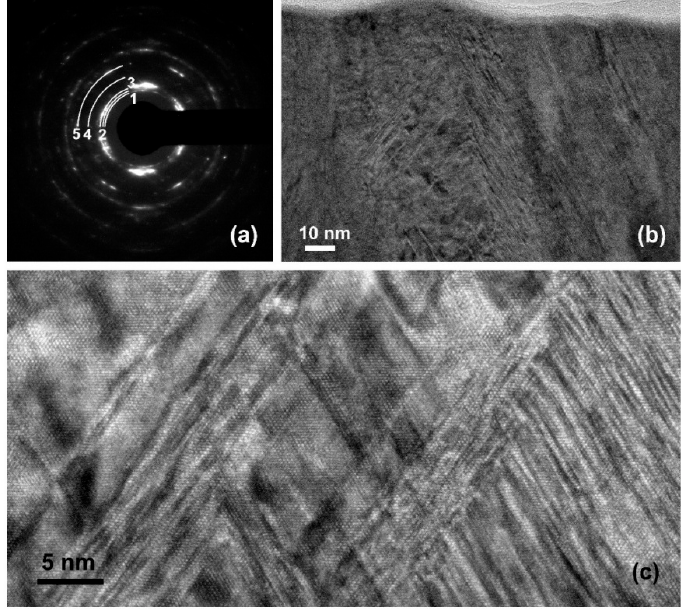
Figure 7. ( a ) SAED pattern, ( b ) Bright-field TEM image of the bulk film structure and ( c ) cross-section HRTEM image of the 15% N 2 film.